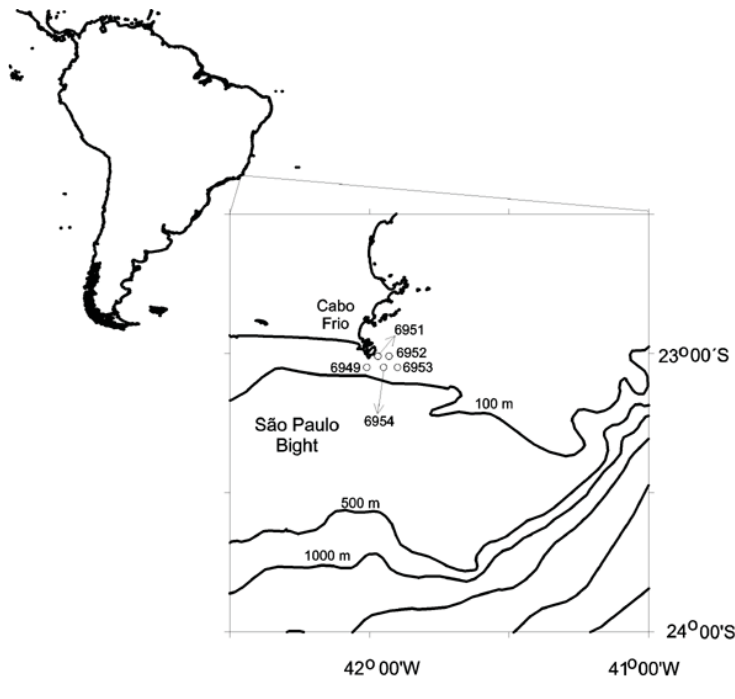
Fig. 1 – Location of the study